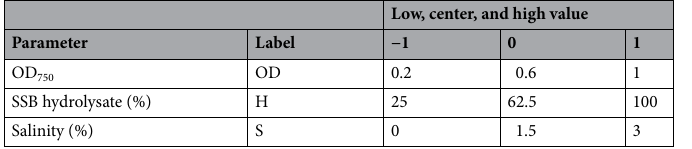
Table 1. Range and coded values for the three independent variables studied in the BBD design of algae cultivation: cell density (OD